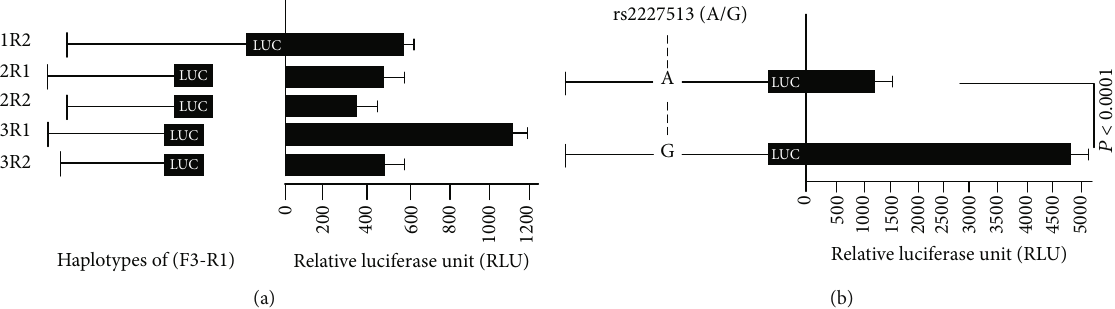
Figure 1: Luciferase activity assay for fragments containing the promoter of IL - 22 gene. (a) Nested deletions of the promoter region were generated and cloned. The clones were then transfected in HEK293 cell line for 48 h. Cells were harvested and tested for luciferase activity. (b) Two constructs of fragment F3R1 containing SNP rs2227513 were generated. One clone harbored A allele and the other clone contained G allele of SNP rs2227513. Luciferase activity was performed as shown in